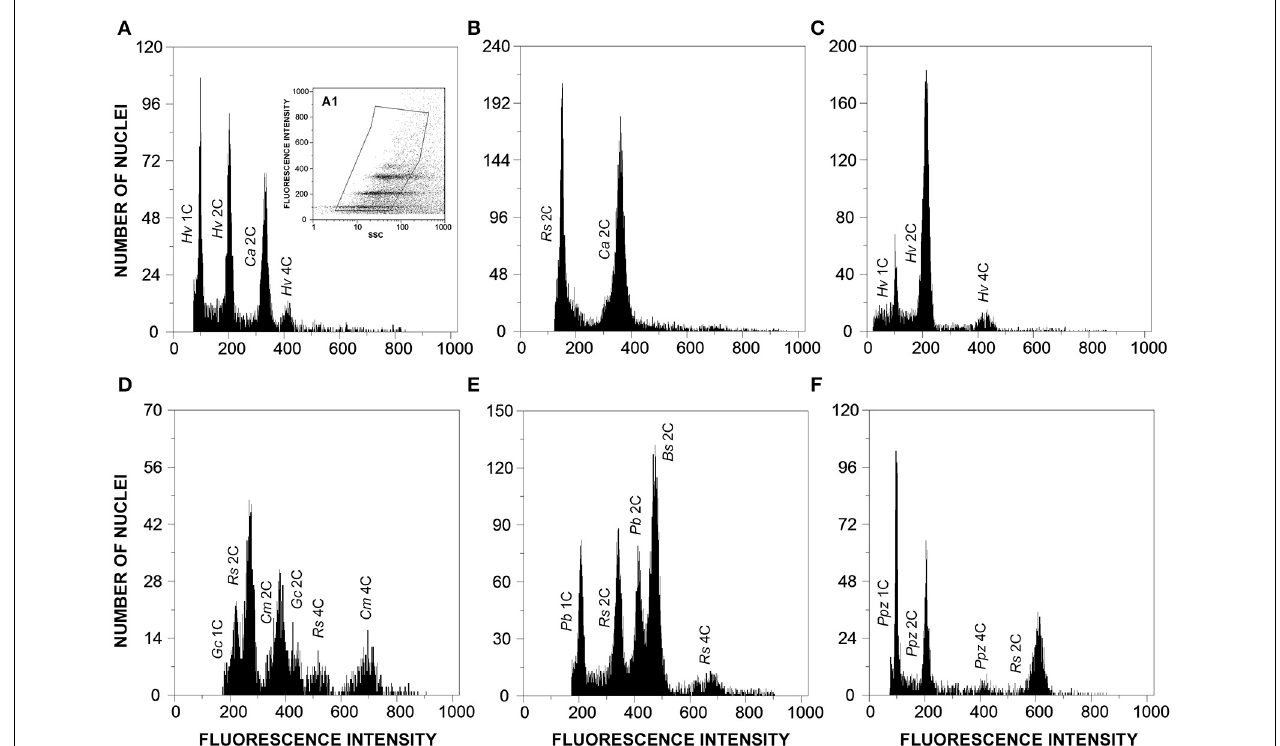
FIGURE 3 | Flow cytometric histograms of relative fluorescence intensities of propidium iodide-stained nuclei simultaneously isolated from: (A) Hemileia vastatrix ( Hv ) and its host plant, Coffea arabica ( Ca ; 2C = 2.49pg DNA); (B) Coffea arabica (Ca) and the plant DNA reference standard, Raphanus sativus ( Rs , 2C = 1.11pg DNA); (C) Hemileia vastatrix ( Hv ) hyphae obtained upon germination of urediniospores in water; (D) Gymnosporangium confusum ( Gc ), its host plant, Crataegus monogyna